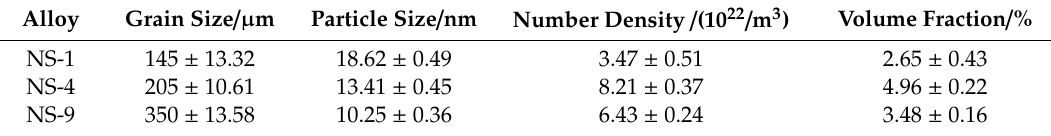
Table 3. Quantitative measurements of NS-1, NS-4, and NS-9 alloys.